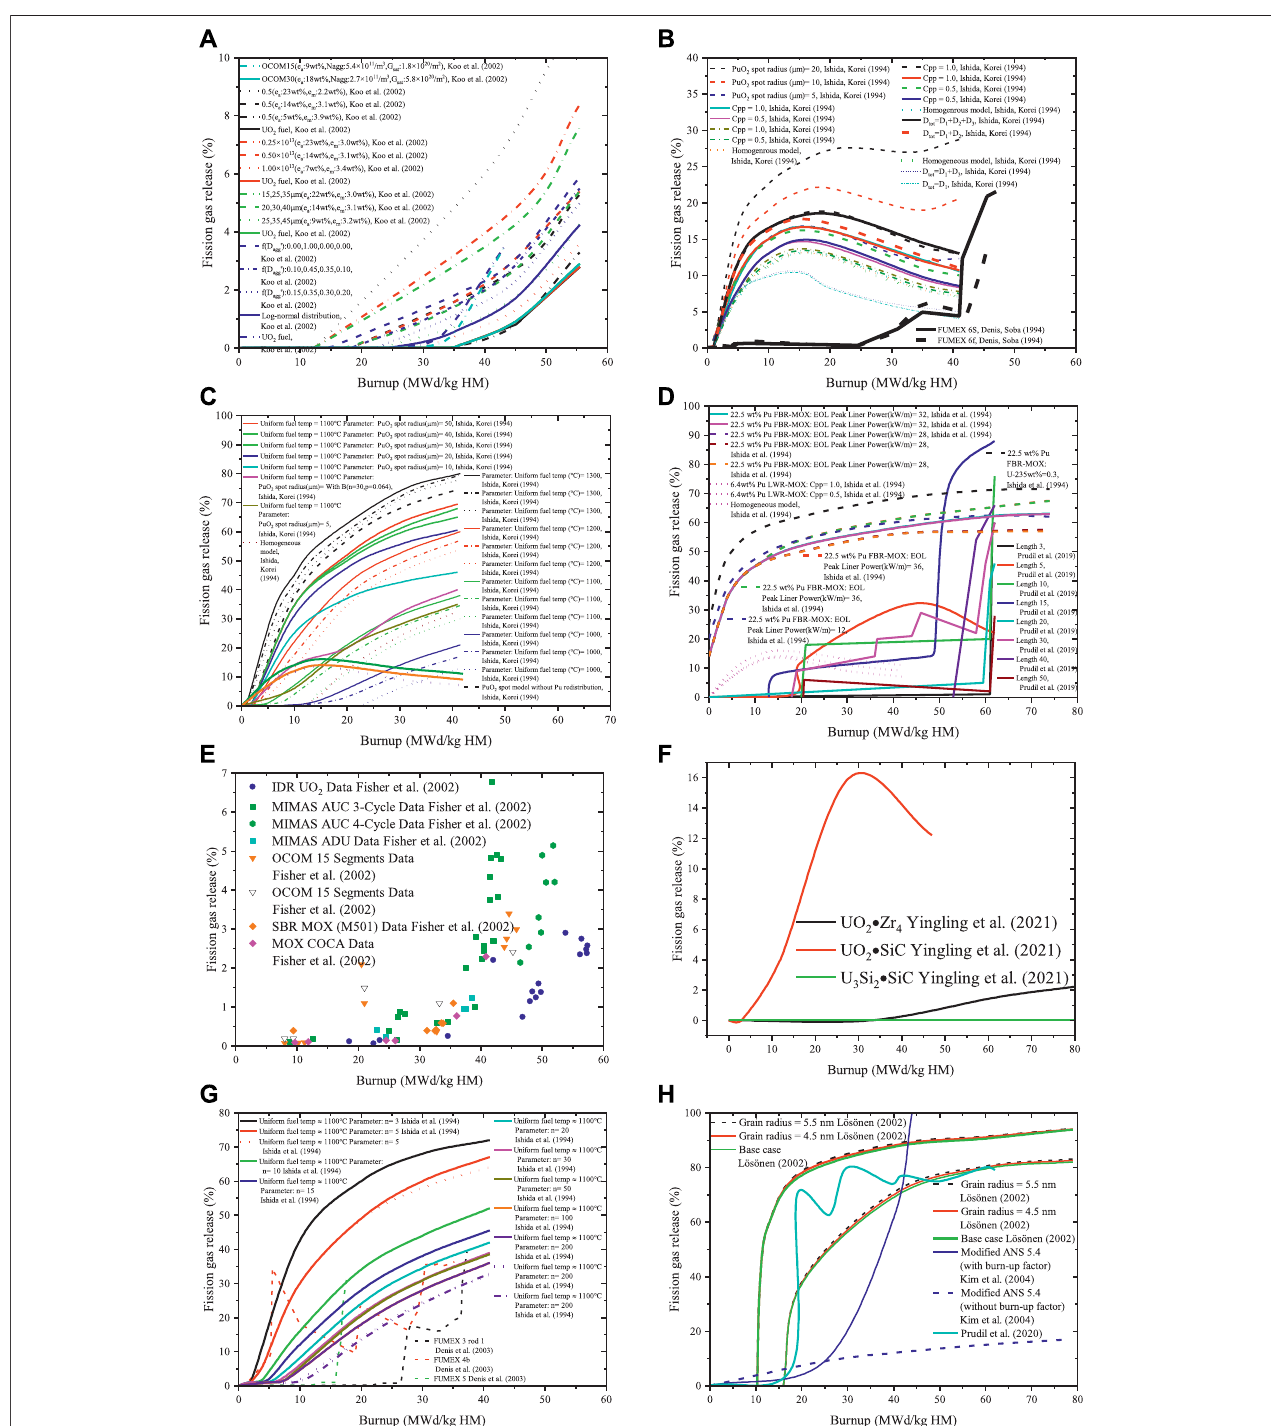
FIGURE2|(A – D) FissiongasreleasewithburnupintheMOX fuel(Ishidaet al.,1994;Kooetal.,2002;Prudilet al.,2019). (E – H) Fissiongasreleasewithburnupin the MOX, U 3 Si 2 and UO 2 fuels (Ishida et al., 1994; Fisher et al., 2002; L ӧ s ӧ nen, 2002; Denis et al., 2003; Kim et al., 2004; Prudil et al., 2020; Yingling et al., 2021). (I – L) Fissiongasrelease with burnup in the metallic and UO 2 fuels (Hwang et al., 2000; Leeet al.,2001; Karahanet al.,2009;Rest, 2012; Verdolin et al.,2020). (M – P) Fission gas release with burnup in the UO 2 , UN, UC and TRISO fuels (Prajoto et al., 1978; Storms, 1988; Vaidyanathan et al., 1993; Koo et al., 2000; Zhang et al., 2020). (Q – T) Fission gas release with time in the UO 2 and metallic fuels (White et al., 1983; Bernard et al., 2002; Koo et al., 2002; King et al., 2011; Pastore et al., 2013; Barani etal.,2020;Cheetal.,2021). (U – X) FissiongasreleasewithtimeintheUC,U 3 Si 2 ,MOX,metallicandUO 2 fuels(Prajotoetal.,1978;Satoetal.,2011;Millettetal.,2012;